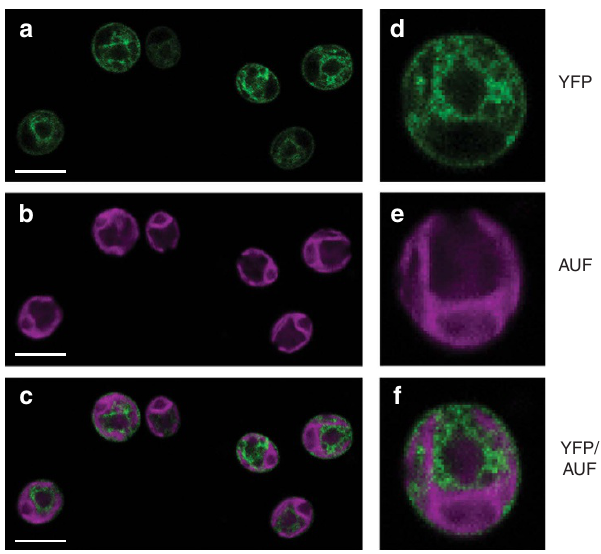
Figure 2 | Chloroplast localization of calredoxin in C. reinhardtii. Microscopy images of a transgenic strain expressing ble-2A-calredoxin- mVenus . ( a , d ) YFP fluorescence (detected with a 525–555nm filter) and ( b , e ) chlorophyll fluorescence (AUF, detected with a 690–740nm filter). Merged images (YFP/AUF) are shown in the bottom row ( c , f ). The second row ( d – f ) shows the fluorescence signals in a single cell at higher magnification. Scale bars, 20 m resolving cysteine in the active site of the TRX domain. The potential targets were eluted with 10 mM dithiothreitol (DTT), digested tryptically and analysed by mass spectrometry. The log2 intensities after label-free protein quantification of the C241S sample were plotted either against the intensities of the WT (Fig. 3a) or the C238S (Fig. 3b) sample. Most proteins were detected at equal ratios (black line represents ratio ¼ 1).